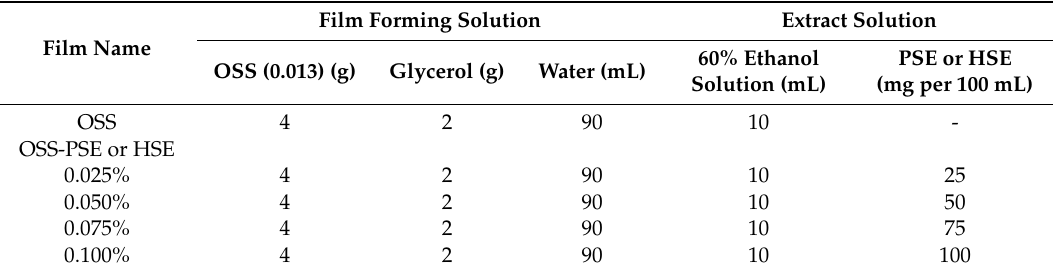
Table 1. Octenyl succinate starch films’